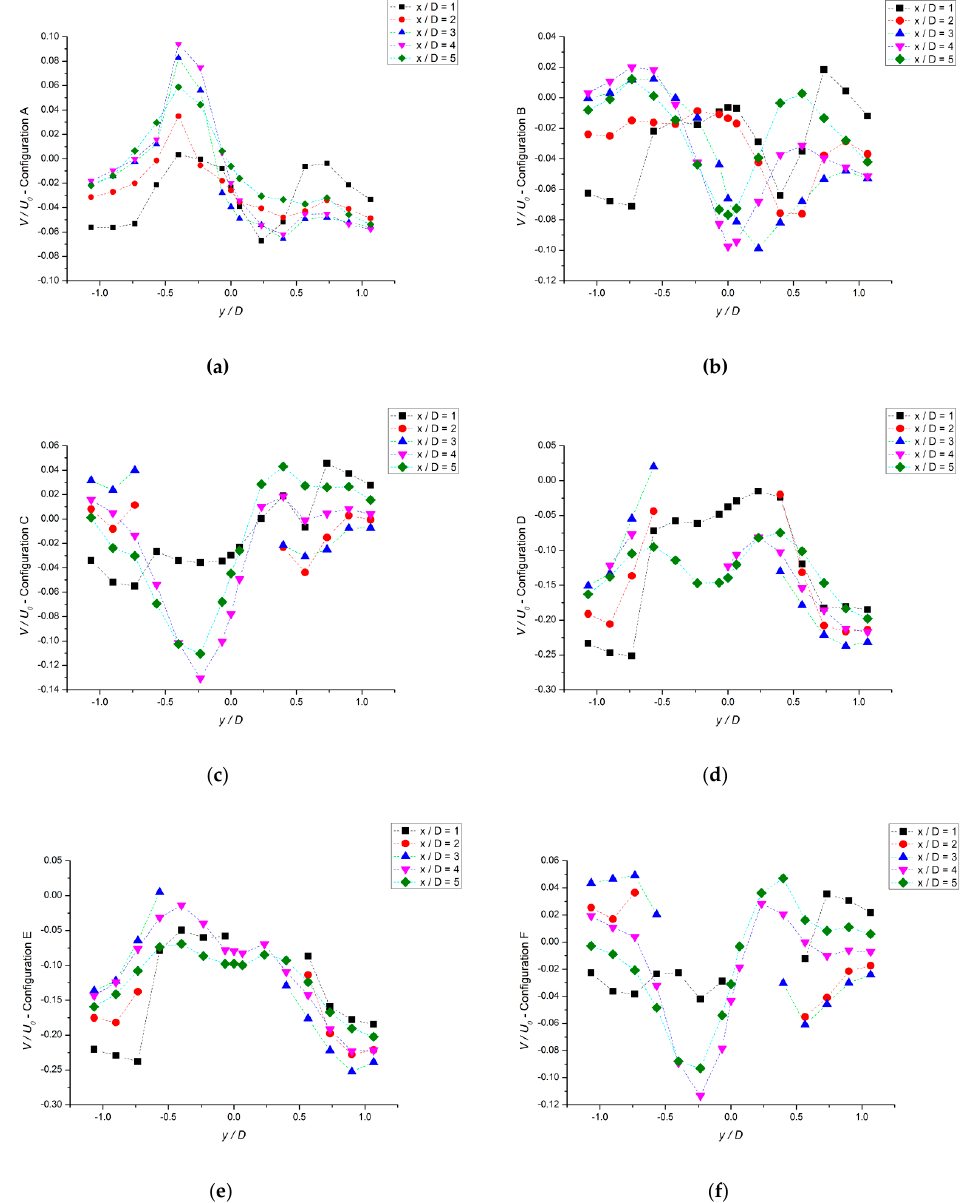
Figure 5. The distribution of the spanwise velocity component for ( a ) configuration A, ( b ) configuration B, ( c ) configuration C, ( d ) configuration D, ( e ) configuration e, ( f ) configuration